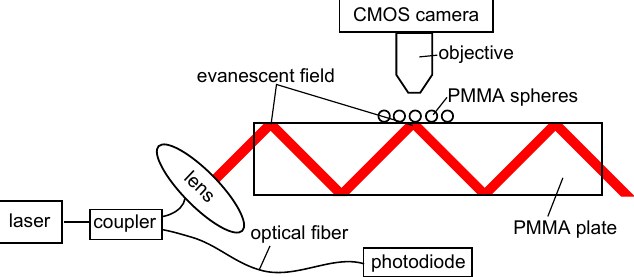
Figure 1. Experimental setup: Ten percent of the laser intensity is detected with a photodiode for calibration purposes. The remaining ninety percent of the laser intensity is collimated and coupled under 45 ◦ in a PMMA plate and guided based on total internal reflection. PMMA spheres supporting the whispering gallery modes (WGMs) are placed in the evanescent field present at the plate surface. The light distribution is captured by a CMOS camera equipped with a microscope